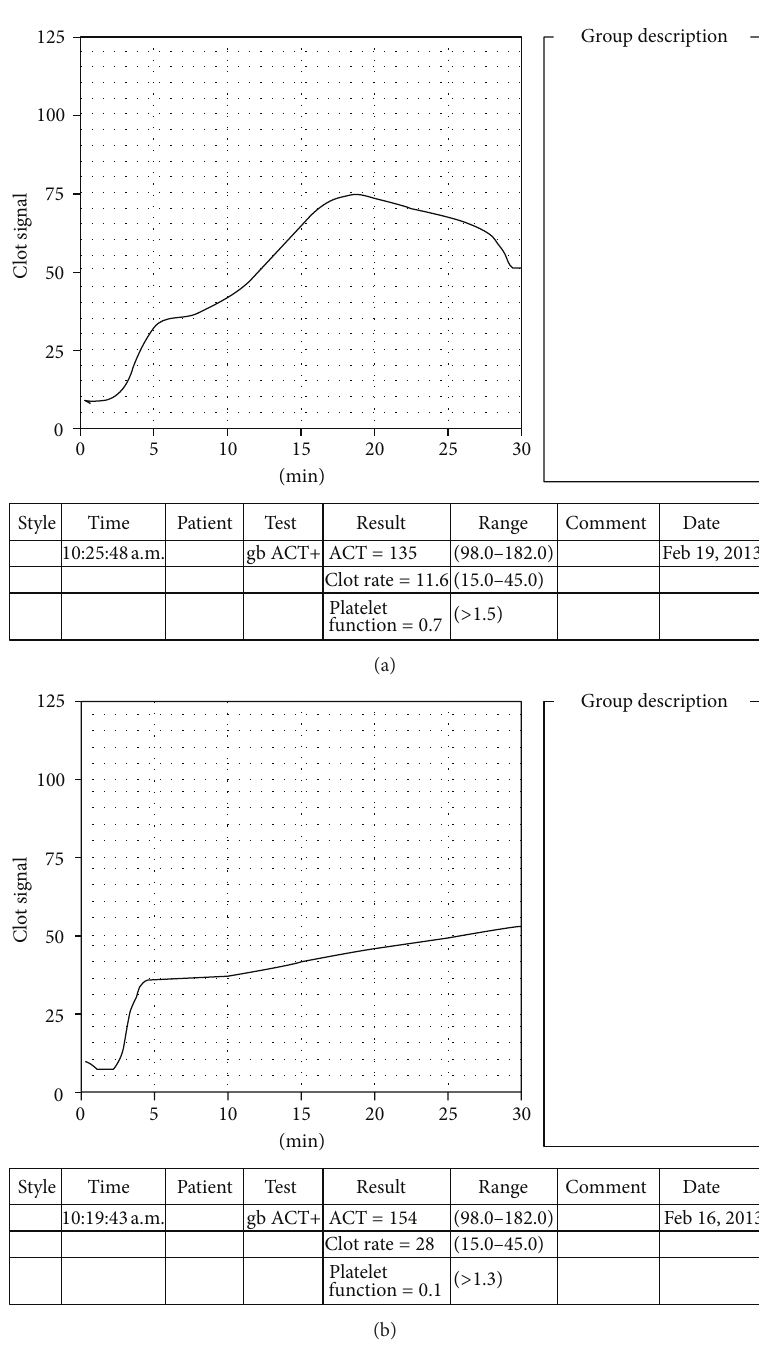
Figure 2: (a) Dull rounded peak on sonoclot signature. (b) Flat sonoclot